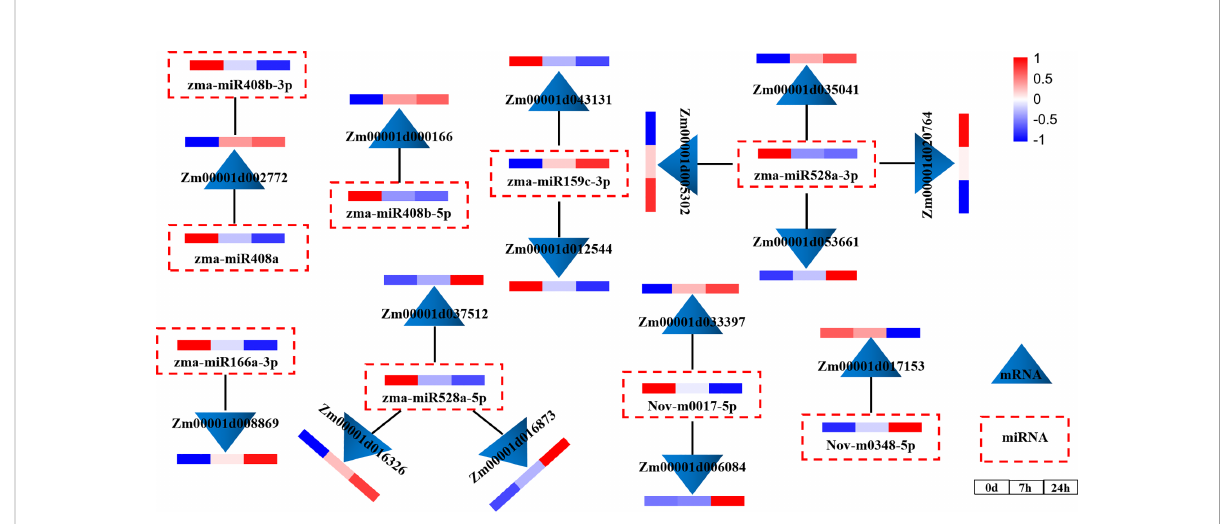
FIGURE 4 miRNA and mRNA co-expression network diagram. Network analysis was performed using the Cytoscape network